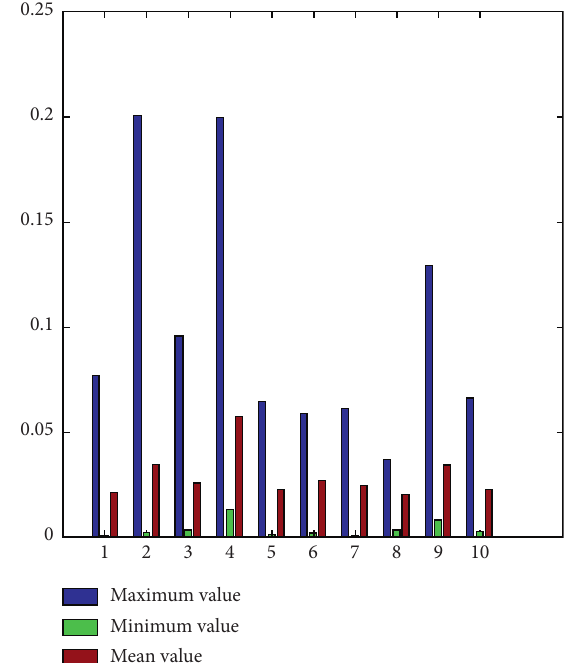
Figure 8: Angles between the proposed method and the standard MKPCA for 10 fashion products in Fashion MNIST (metric: radian).